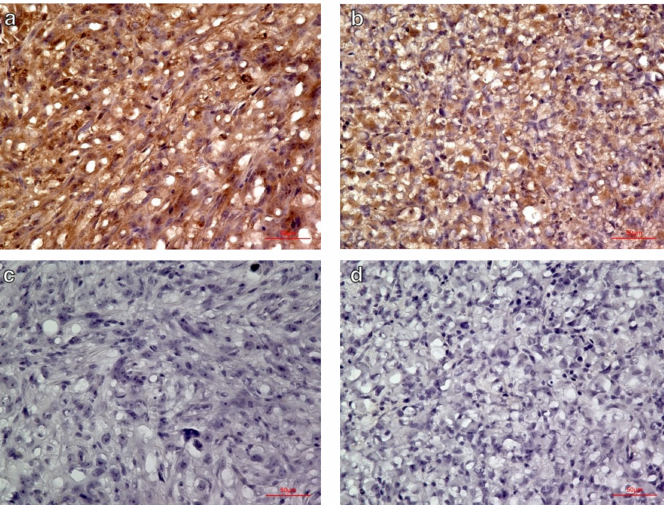
Figure 5. Immunohistochemical labeling of integrin α v β 3 in ( a ) C6 glioma, ( b ) MIA PaCa-2 xenografts, and negative controls of ( c ) C6 glioma and ( d ) MIA PaCa-2 without primary antibody (magnifica- tion × 400). The C6 glioma showed more intense expression of integrin α V β 3 than did the MIA